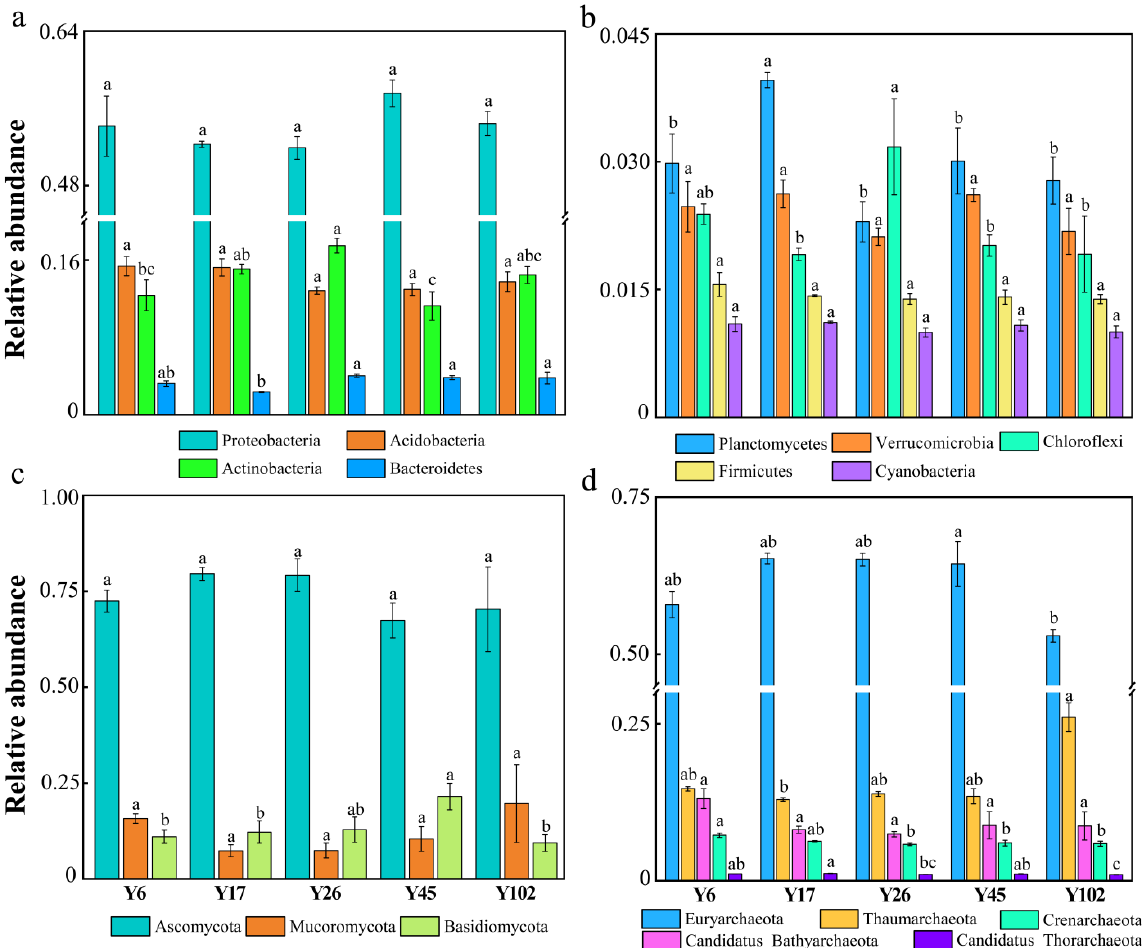
Figure 2. Relative abundance of the dominant phyla of bacterial ( a , b ), fungal ( c ) and archaeal ( d ) communities. Values are means, and error bars show standard error (n = 3). Different letters above the bars indicate significant differences between stand groups for each phylum ( p < 0.05).